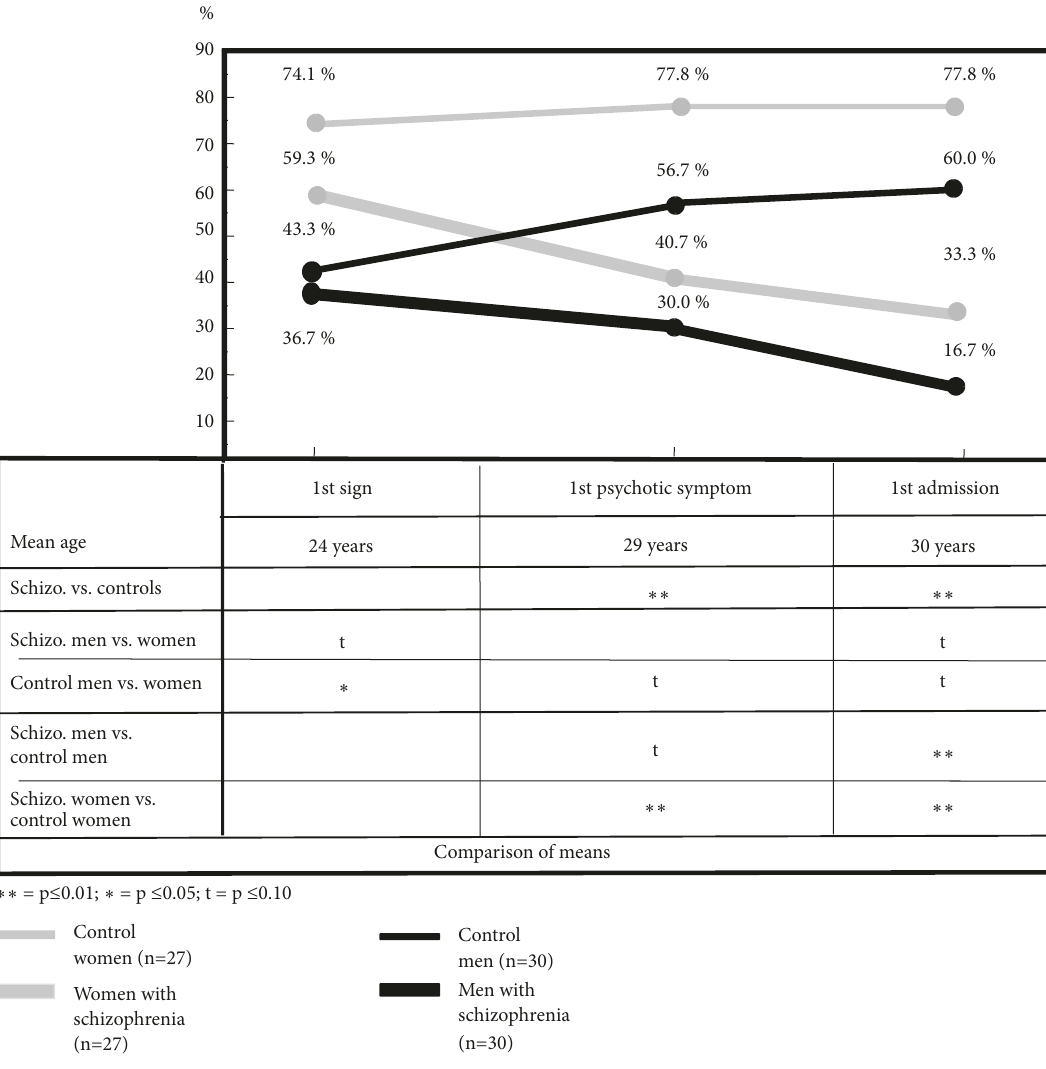
Figure 9: Marriage or stable partnership. Source: